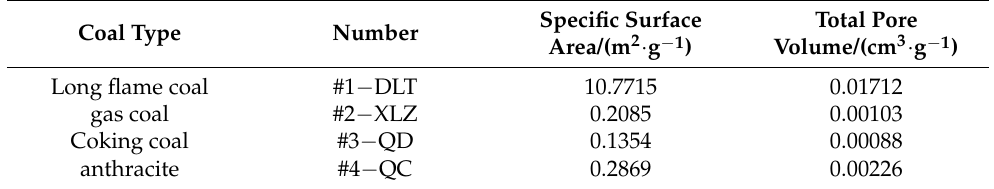
Table 3. Specific pore surface area and total pore volume of adsorption pores of 4 experimental samples.